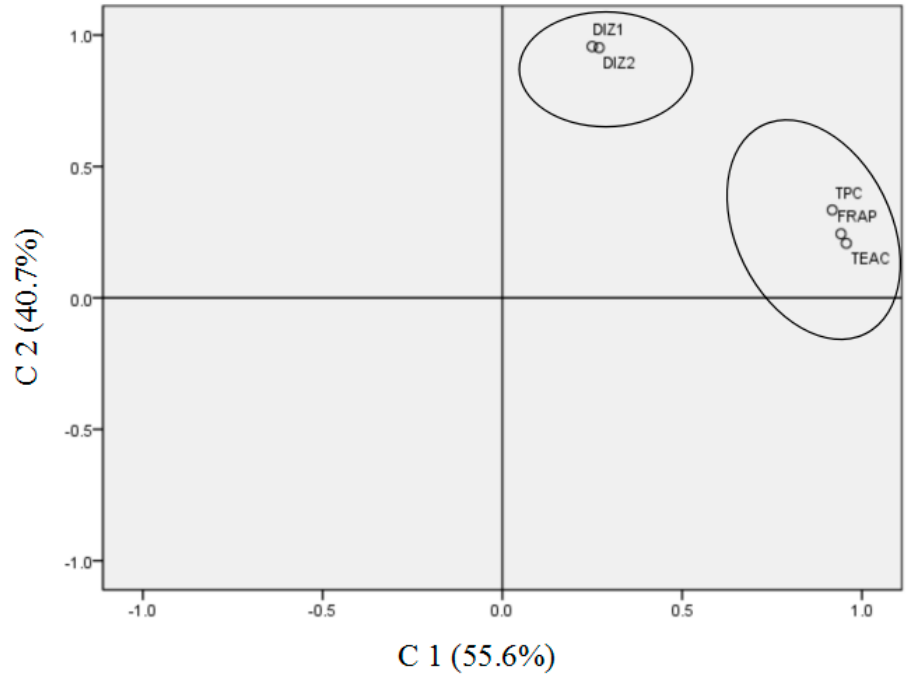
Figure 2. The results of principal component analysis (PCA). C1 included the factors total phenolic content (TPC), ferric-reducing antioxidant power (FRAP), and trolox equivalent antioxidant capacity (TEAC), suggesting that TPC was closely related to the antioxidant capacity. C2 contained DIZ values of S. aureus ATCC 25923 (DIZ1) and drug resistant S. aureus SJTUF 20978 (DIZ2). C1 and C2 were clearly divided into two separate clusters, suggesting that there was no evident relationship of antibacterial capacity with antioxidant ability and TPC.